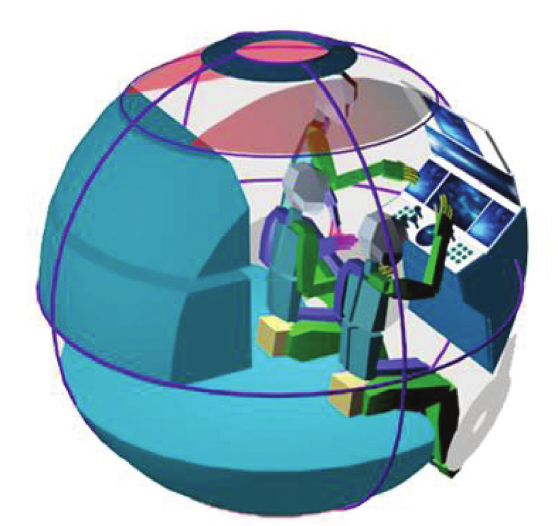
Figure 12: Cabin layout optimized by genetic algorithm after deconstruction and